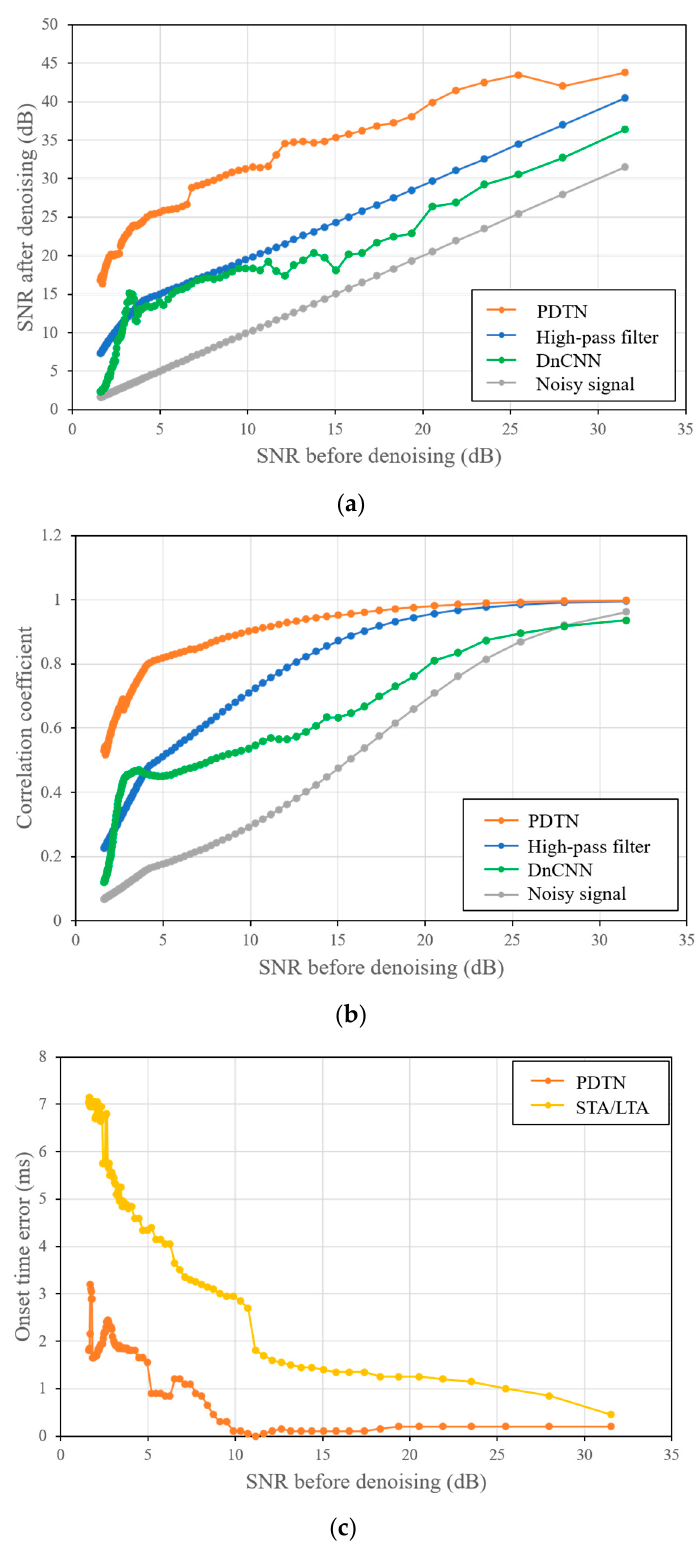
Figure 6. Contrast diagram of PDTN, DnCNN, high-pass filter, and STA/LTA denoising and onset time picking effect. ( a ) SNR curves of noisy signals and signals denoised using PDTN, DnCNN, and high-pass filtering. ( b ) The correlation coefficients between the clean microseismic signal and the signal denoised using the high-pass filter, DnCNN, and PDTN. ( c ) The onset time error of noisy signals detected using PDTN and STA/LTA.